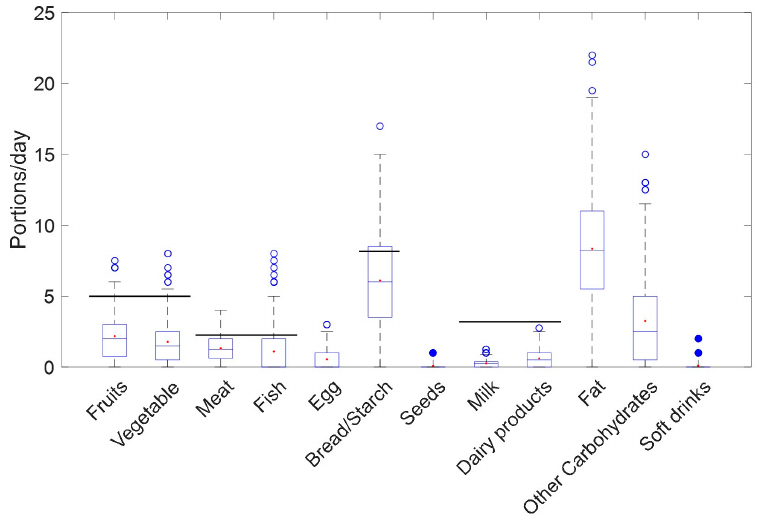
Figure 1. R24h food groups intake in lactating mothers. Note: Horizontal black line represents recommended intake according to the World Health Organization diet guidelines for lactating mothers. (Red dot = median; blue circle (open) = standard outlier (1.5 - 3.0 × IQR); blue circle (closed) = extreme outlier ( ≥ 3.0 × IQR)).